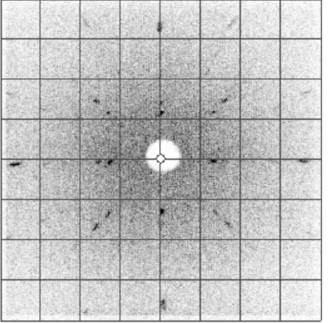
Figure 3. Laue image along (100) direction of the dominant grain on the front face of the cube. All peaks were indexed to the (100) direction, verifying the single grain portion of this material. The four-fold symmetry of the pattern is characteristic for the (100) direction of a cubic crystal.